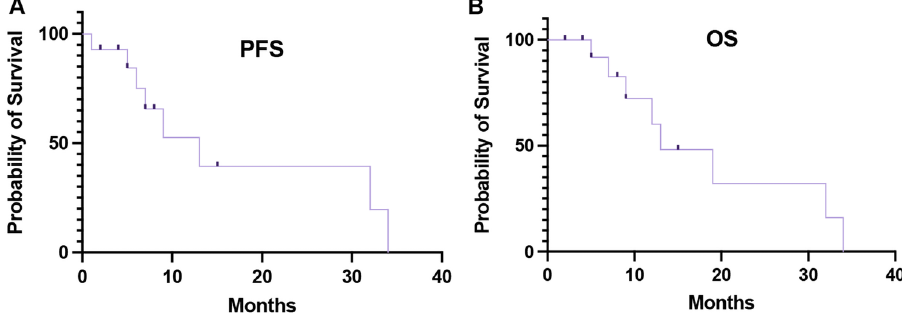
Fig. 3 A , B Kaplan–Meier curves for progression-free survival ( A ) and overall sur- vival ( B ) in the